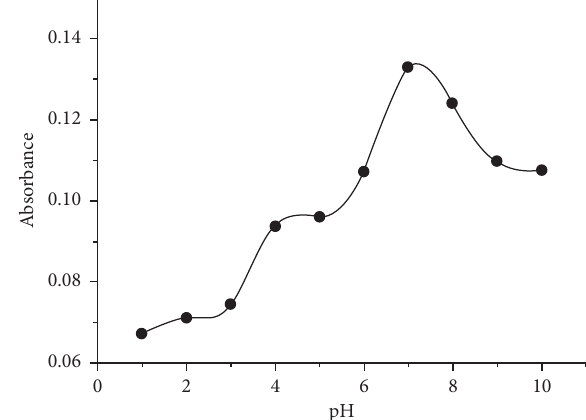
Figure 3: Effect of pH on the absorbance of the Pd(II)- p -ITYBA complex at a wavelength of 450nm (C p -ITYBA � 5.0 × 10 − 5 mol · L − 1 ; C R d( __ ) � 2.50 × 10 − 5 mol · L − 1 ; C N a Cl � 0.10mol · L − 1 ; C UBS � 0.020mol · L − 1 ; l �